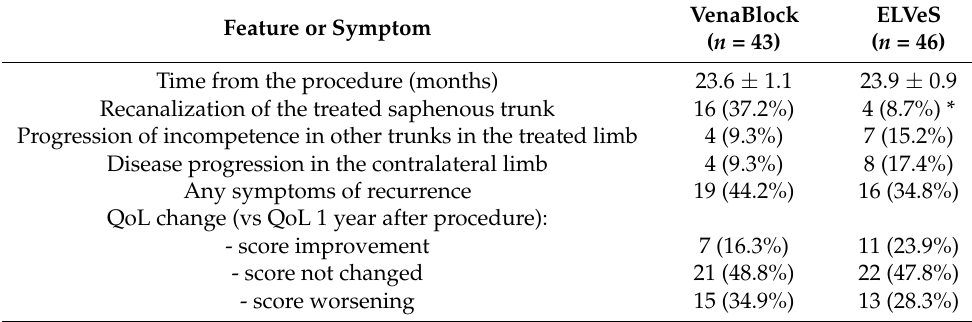
Table 3. Summary of the main features and symptoms of disease progression assessed 2 years after procedure. Values given in table represent the mean ± standard deviation, or patient number (percent) in the group, respectively. Statistically significant differences were marked with asterisks (* p <